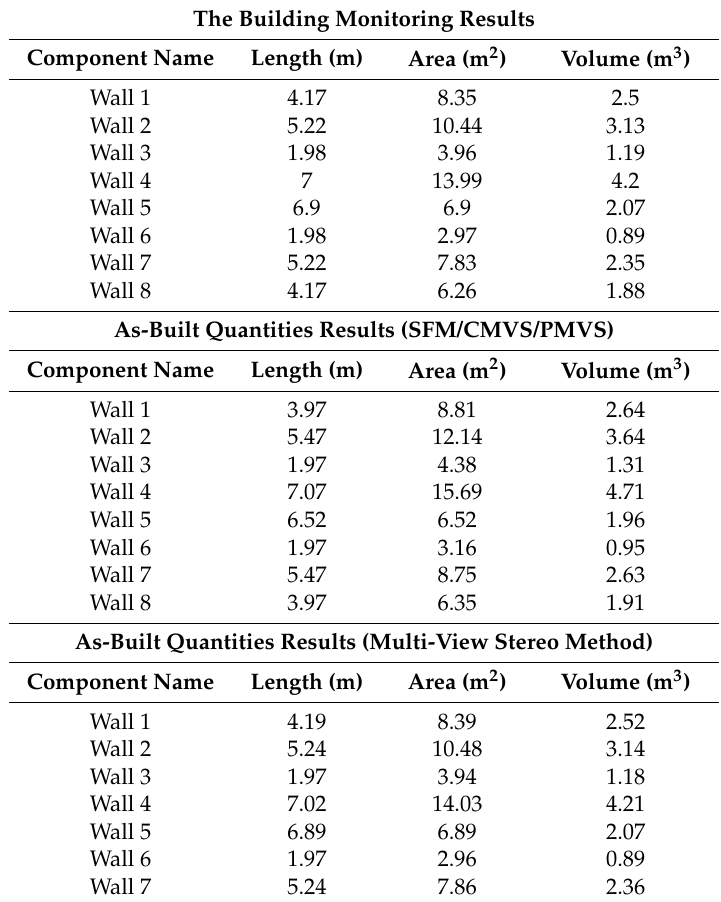
Table 5. The quantities of performed work determined by the proposed photogrammetric Multi-View Stereo method and SFM/CMVS/PMVS algorithm (case study